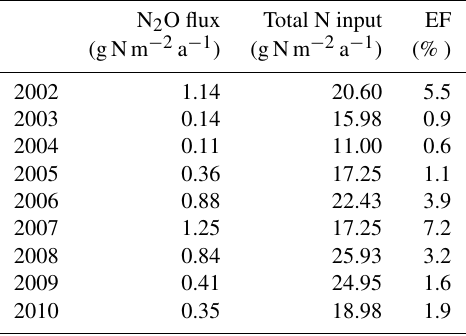
Table 5. Annual N 2 O exchange, total N input by fertiliser (mineral and organic) and N 2 O emission factors, expressed as a percentage of total N inputs in 2002–2010.